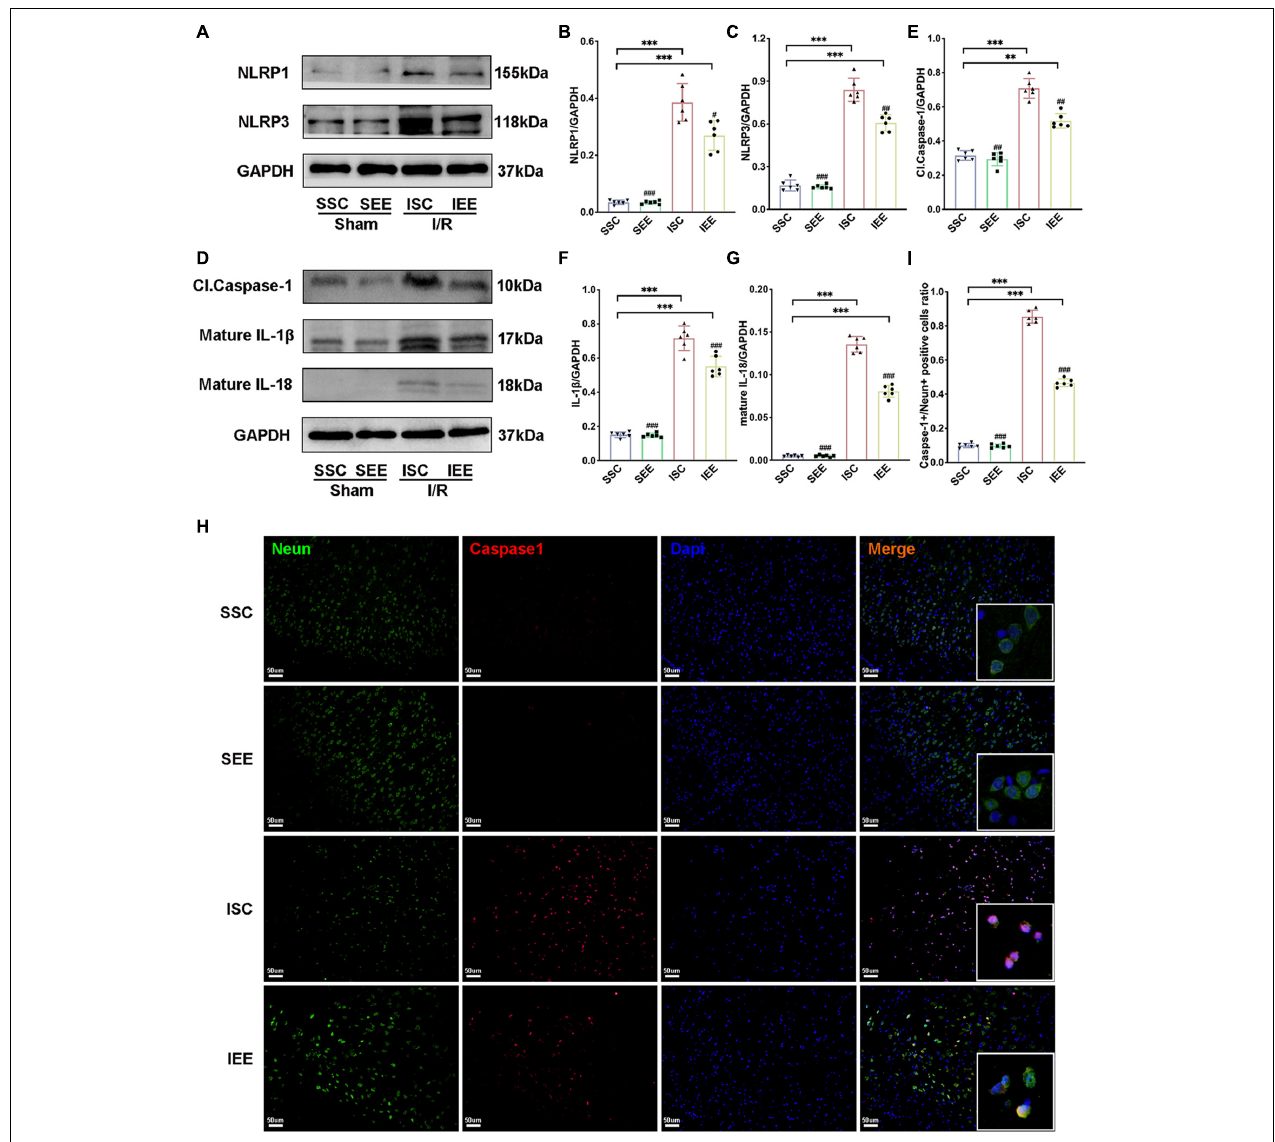
FIGURE 4 | Enriched environment suppressed the activities of NLRP1/NLRP3 inflammasomes of MCAO/R rats. (A–G) Western blots and quantification of NLRP1/NLRP3 inflammasomes related proteins including NLRP1, NLRP3, cleaved caspase-1, mature IL-1 β , and IL-18 in peri-infarct tissues. n = 6. (H,I) Double immunostaining of Neun and Caspase-1 revealed a good co-localization of these two makers. Statistical analysis of the positive rate is shown. Treatment with EE reduced Caspase-1 positive neurons in the ischemic penumbra. Scale bars, 50 µ m. n = 6. Data are expressed as mean ± SD. ** p < 0.01, *** p < 0.001 vs. SSC group; # p < 0.05, ## p < 0.01, ### p < 0.001 vs. ISC